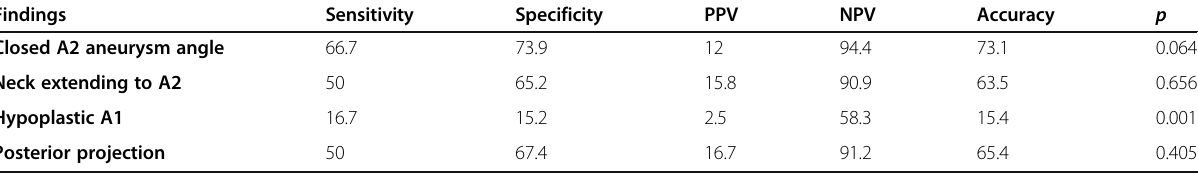
Table 3 Performance of CTA findings in prediction of postoperative morbidity among the studied patients